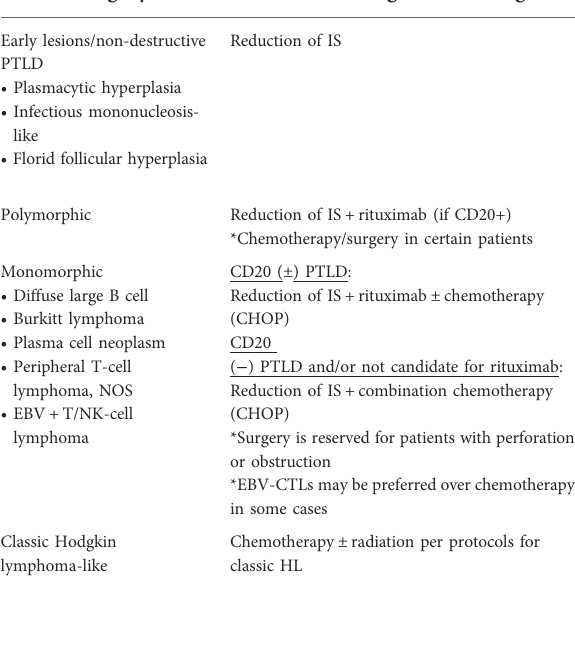
TABLE 1 Overview of management strategies based on classi fi cation of PTLD. PTLD